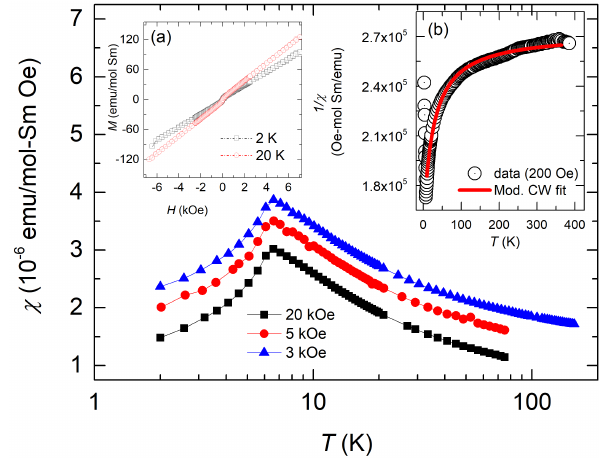
Figure 2. The magnetic susceptibility χ ( T ) of Sm 3 Co 4 Ge 13 in zero field-cooling mode at applied fields of 3 kOe, 5 kOe and 20 kOe. A magnetic phase transition at T N ≈ 6 K is evident. The inset ( a ) shows the magnetization isotherms, M ( H ) , at 2 K and 20 K. The inset ( b ) displays the inverse susceptibility at 200 Oe along with a modified Curie Weiss fit (Equation